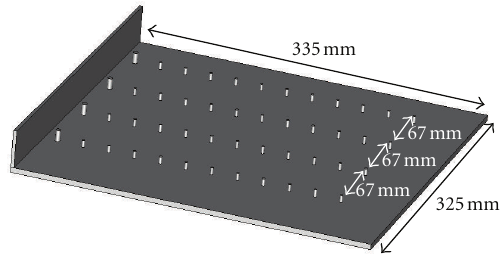
Figure 21: Array of 4 × Yagi antenna.